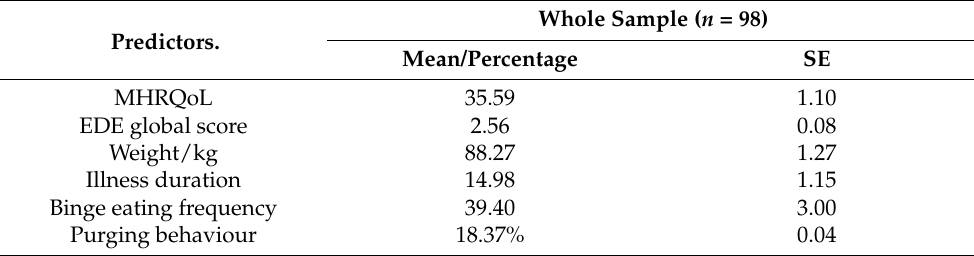
Whole Sample ( n = 98)